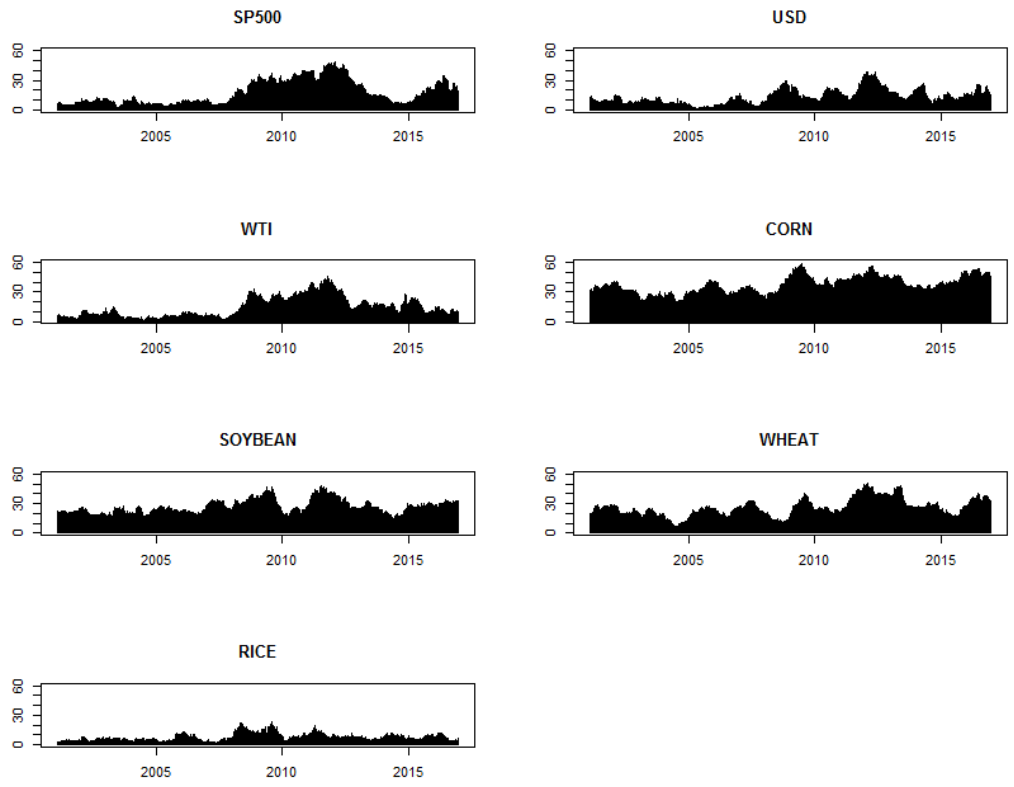
Figure 3: Directional volatility spillovers “to others” for seven markets (the lasso